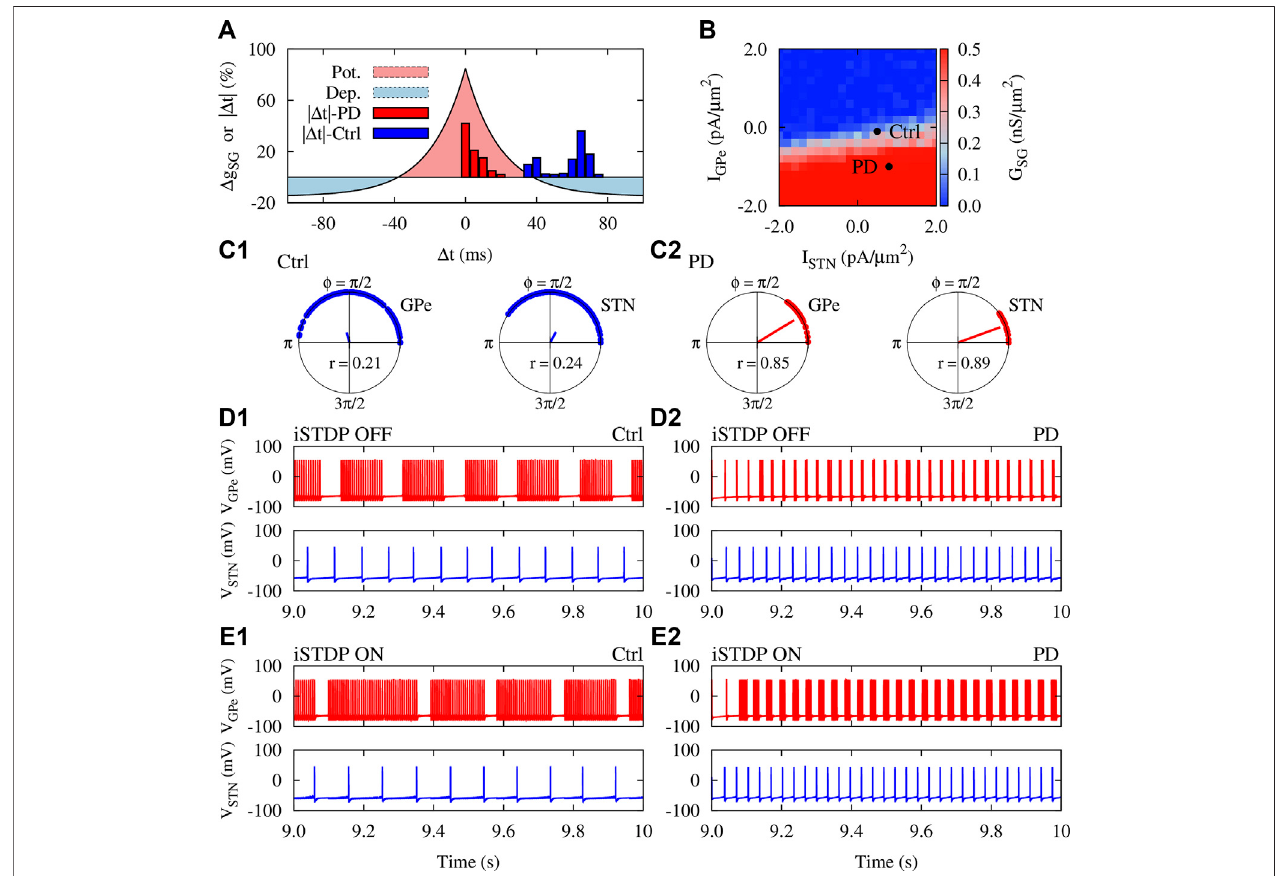
FIGURE 3 | iSTDP shapes neuronal synchrony and inter-population coupling in the GPe-STN network. (A) The iSTDP pro fi le described by Eq. 12 with η = 0.005 nS/ μ m 2 , τ = 20 ms and α = 0.15. Blue (red) boxes show the distribution of time lags between the fi ring of neurons obtained from numerical simulations for control (PD) condition marked in panel (B) (B) Steady-state mean coupling adjusted by iSTDP in the pallido-subthalamic pathway ( G SG ) for different mean currents applied to GPeandSTN.Initialstrengthofindividualsynapseswaspickedfromanormaldistributionaround0.25 nS/ μ m 2 . (C1,C2) PolardistributionofthephasesoftheGPe (left) andSTN (right) neuronsincontrol (C1) and PD (C2) condition.Theradial bardenotes theorderparameterde fi ned in Eq.14 ,where itsvalueisindicated withineach panel. (D1,D2) Examplary time course of the membrane potential of randomly chosen GPe (#68) and STN (#43) neurons in control (D1) and PD (D2) condition when STDP was OFF. Ctrl: I GPe = − 0.1 pA/ μ m 2 , I STN = 0.5 pA/ μ m 2 and PD: I GPe = − 1.0 pA/ μ m 2 , I STN = 0.8 pA/ μ m 2 (marked in panel B). (E1,E2) Same as (D1) and (D2) , but when iSTDP was turned